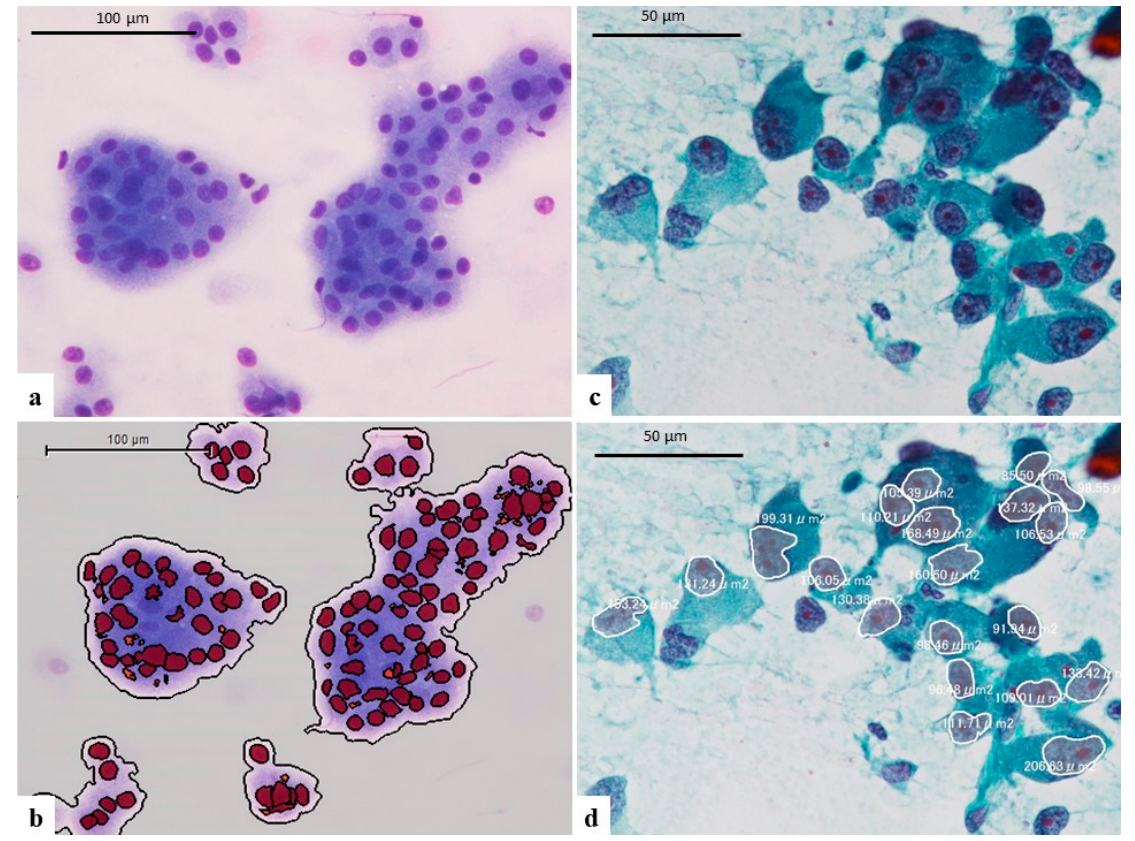
Figure 2. ( a ) The image of Giemsa-stained touch smear cytology of well differentiated HCC ( × 200, same case of Figure 1a). ( b ) Analyzing image of Figure 2a. The software Tissue Studio appropriately recognize the nuclei of tumor cells. ( c ) The image of Papanicolaou-stained touch smear cytology of poorly differentiated HCC ( × 200, same case of Figure 1c). ( d ) Analyzing image of Figure 2c. The nuclei were manually selected and then of the major axis, minor axis, and area of the nucleus were calculated by attaching software of EXpath III.